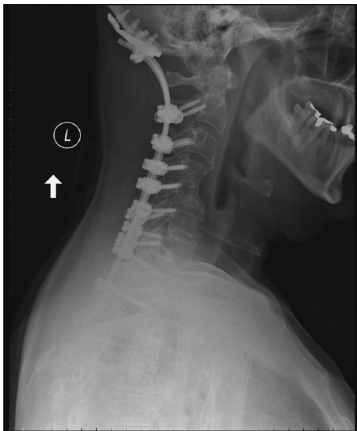
Figure 2: Postoperative lateral X-ray demonstrating posterior instrumentation from the occiput to